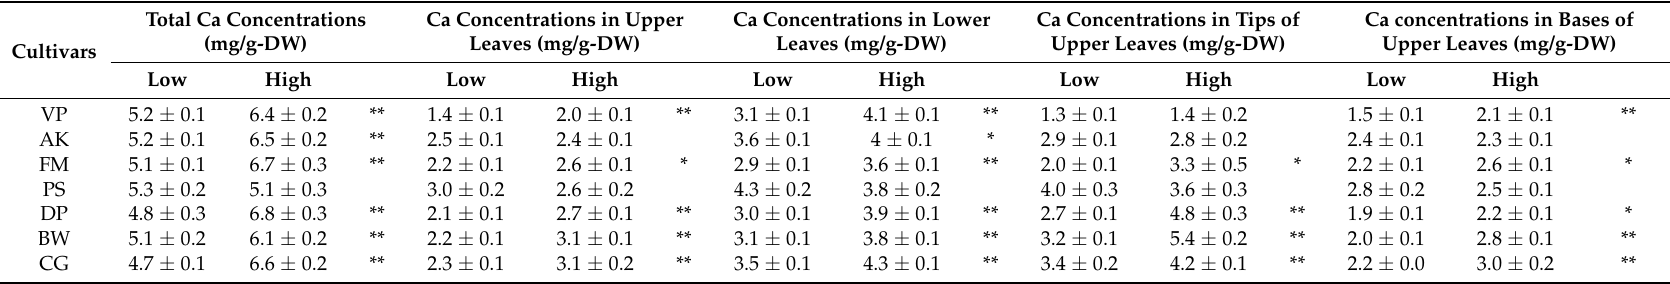
Table 2. Mean total Ca concentrations, Ca concentrations of upper and lower leaves, and Ca concentrations in the tips and bases of upper leaves in seven lisianthus cultivars under low (50%) and high (70%) air humidity